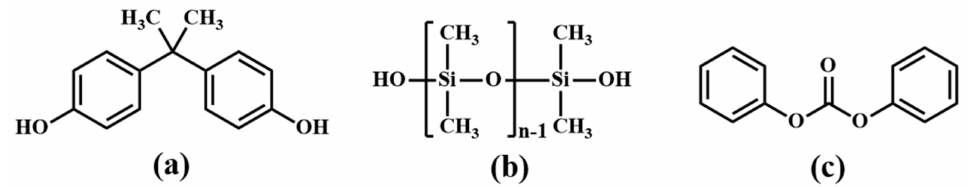
Figure 1. Chemical structures of ( a ) BPA, ( b ) PDMS, and ( c )